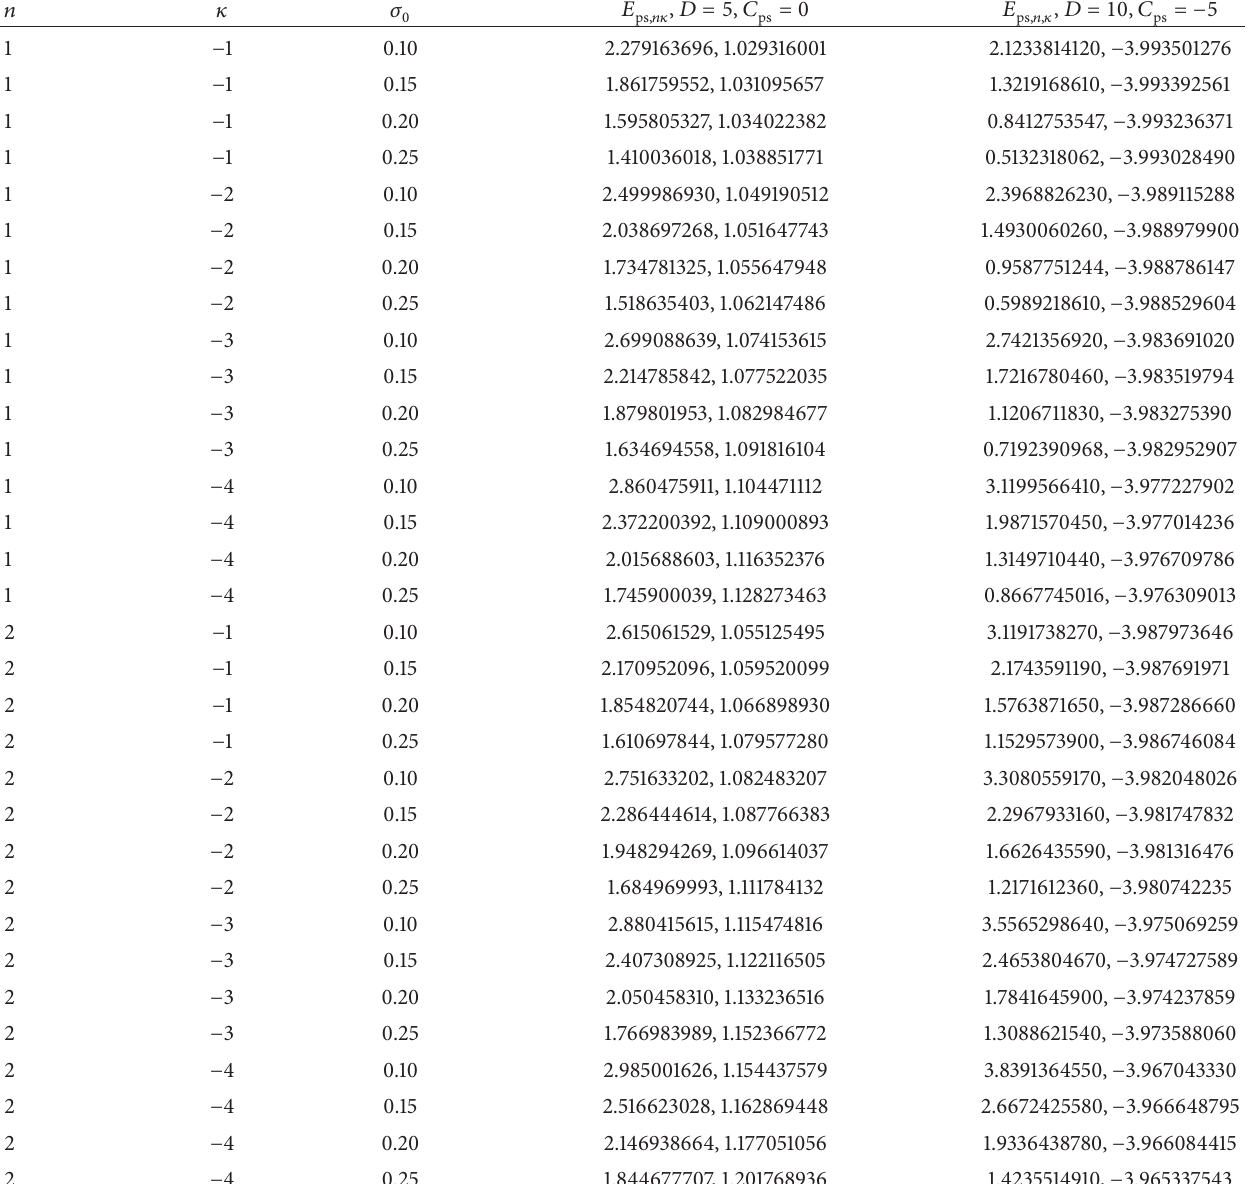
Table 1: Pseudospin symmetry bound state energies at the poles of 𝑠 -matrix (in units fm −1 ) for the hyperbolical potential as a function of positive potential parameter 𝜎 0 for different values 𝑛 and 𝜅 < 0, 𝛼 = 0.1 in atomic units (𝜇 = 7 = 1) , and 𝑐 𝑜 =